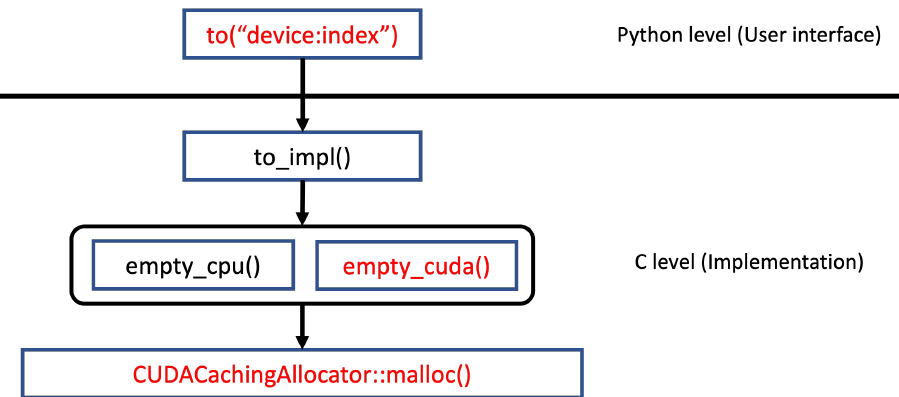
Figure 2. Order of memory allocation function calls via to(“device:index”) . (The functions we modified are colored in